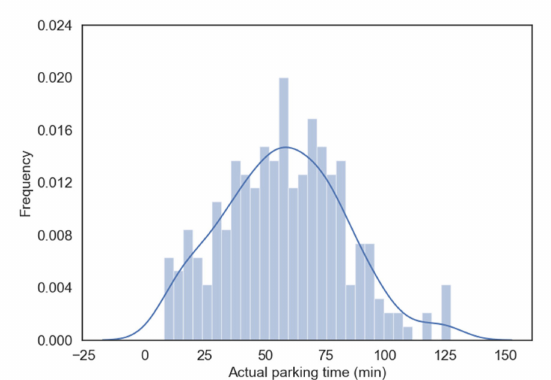
Figure 4. T park of frequency distribution